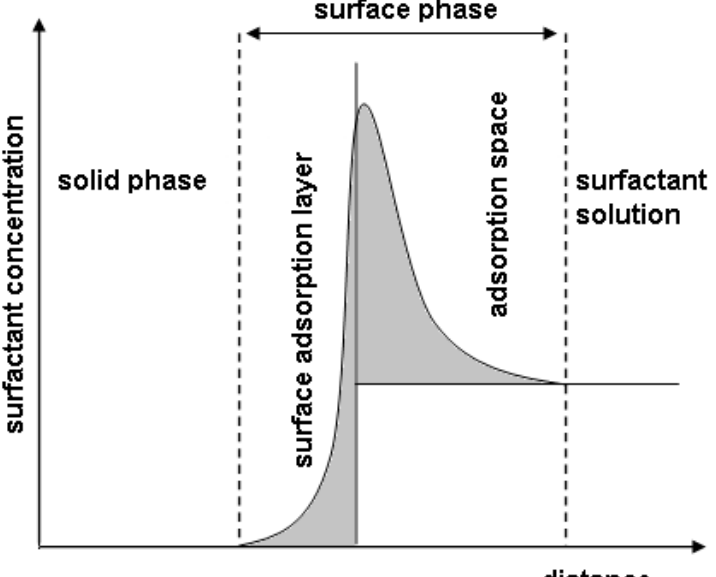
Figure 1. Adsorption at the interface: solid-surfactant solution.